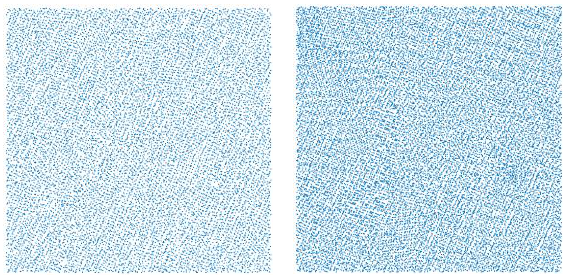
Figure 12. Point patterns for test area n. 3 and for scenarios 1 (left) and 4 (right)